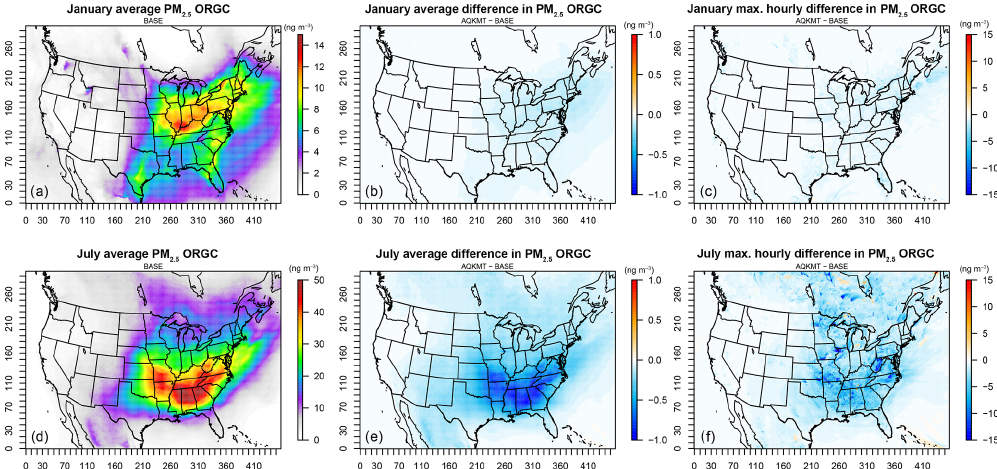
Figure 4. Average baseline (a, d) and average (b, e) and maximum (c, f) hourly difference (AQKMT − Base) in SOA from cloud processing of carbonyls (ngm − 3 ) for January and July 2011 using